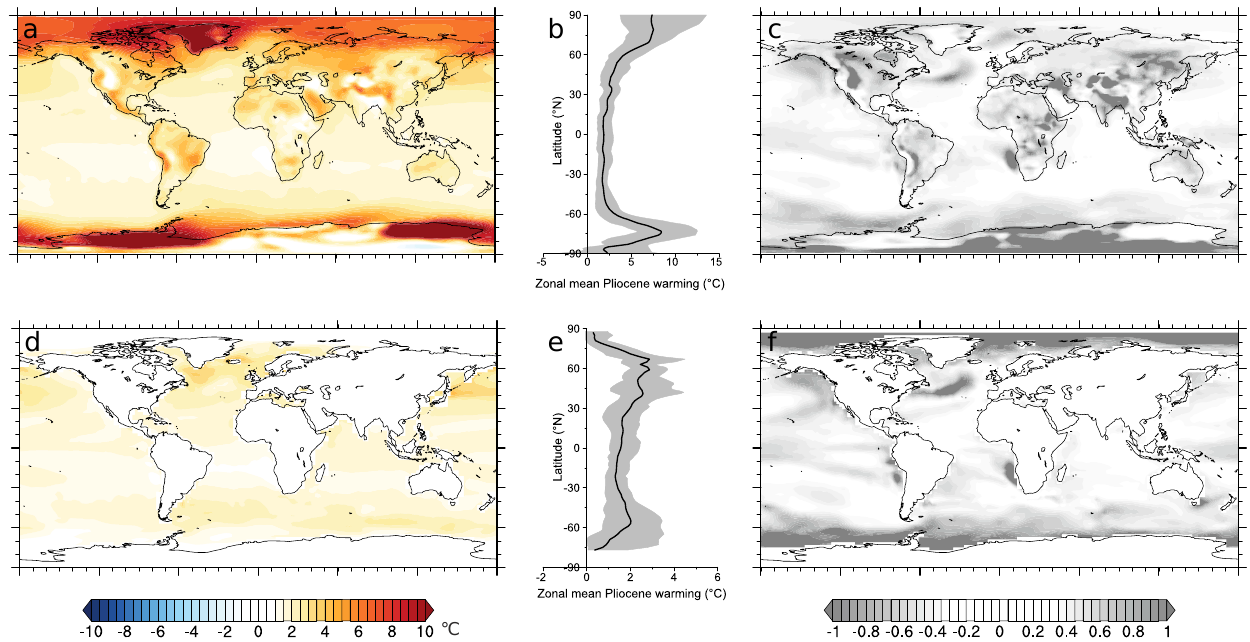
Fig. 1. Multi-model mean PlioMIP Experiment 2 warming between mid-Pliocene and pre-industrial simulations. (a) Annual mean surface air temperature (SAT) warming, (b) zonal mean SAT warming (solid line), with shading showing the range of model simulations, and (c) relative variance between the PlioMIP Experiment 2 simulations ( σ/1 SAT). (d) Annual mean sea surface temperature (SST) warming, (e) zonal mean SST warming and (f) relative variance of